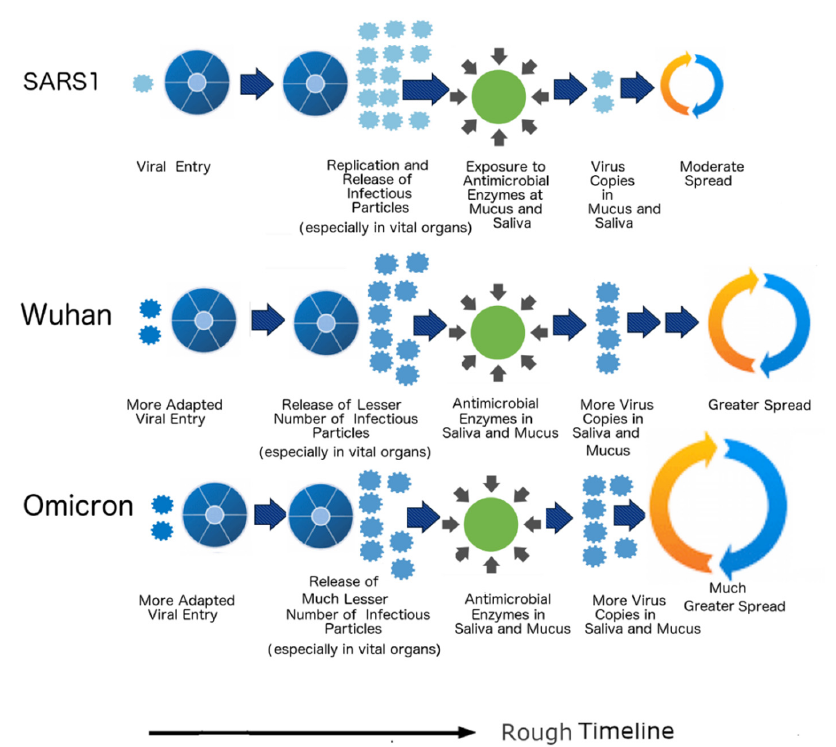
Figure 6. The life cycles of the SARS-CoV-1/2, SARS-CoV-1 (SARS1) produces more infectious particles, especially in vital organs arising from the differences in N PIDs but sheds fewer infectious particles orally and nasally because its outer shell (M) is not as hard and protective as that of SARS-CoV-2. SARS1 and SARS-CoV-2 have different life cycles as a result of the differences in the S proteins. This is denoted by the differences in the lengths of their life cycles and the number of particles at viral entry. Note: Numbers of infectious particles shown are comparative and qualitative illustrations and are not to meant to be exact quantifications.